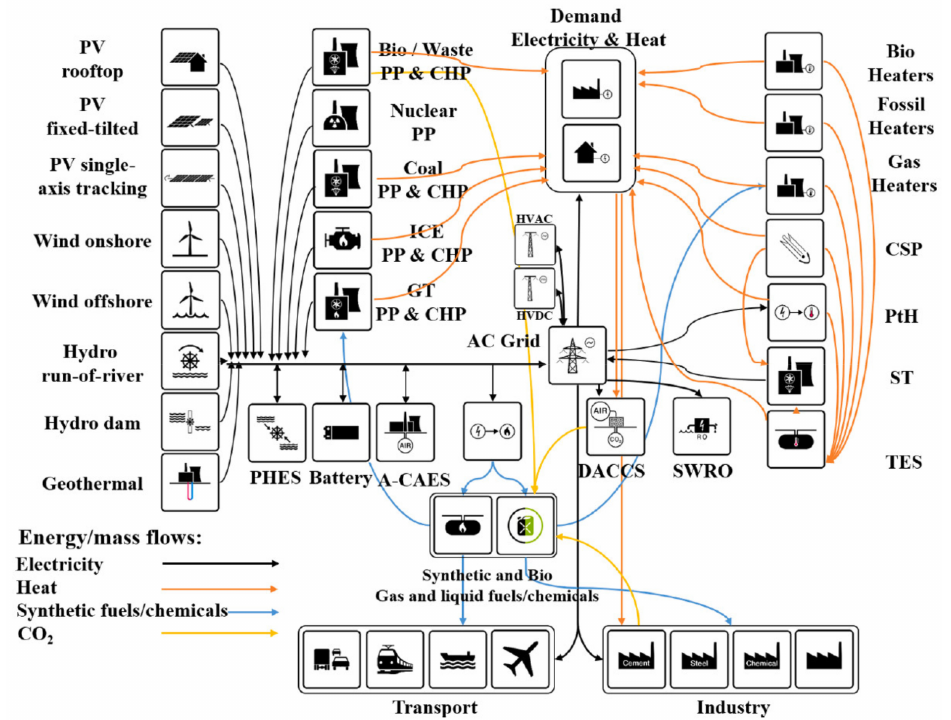
Figure 3. Integration of the energy sectors within the LUT model (Bogdanov et al., 2021 [25]). Reprint with permission; Copyright 2021,